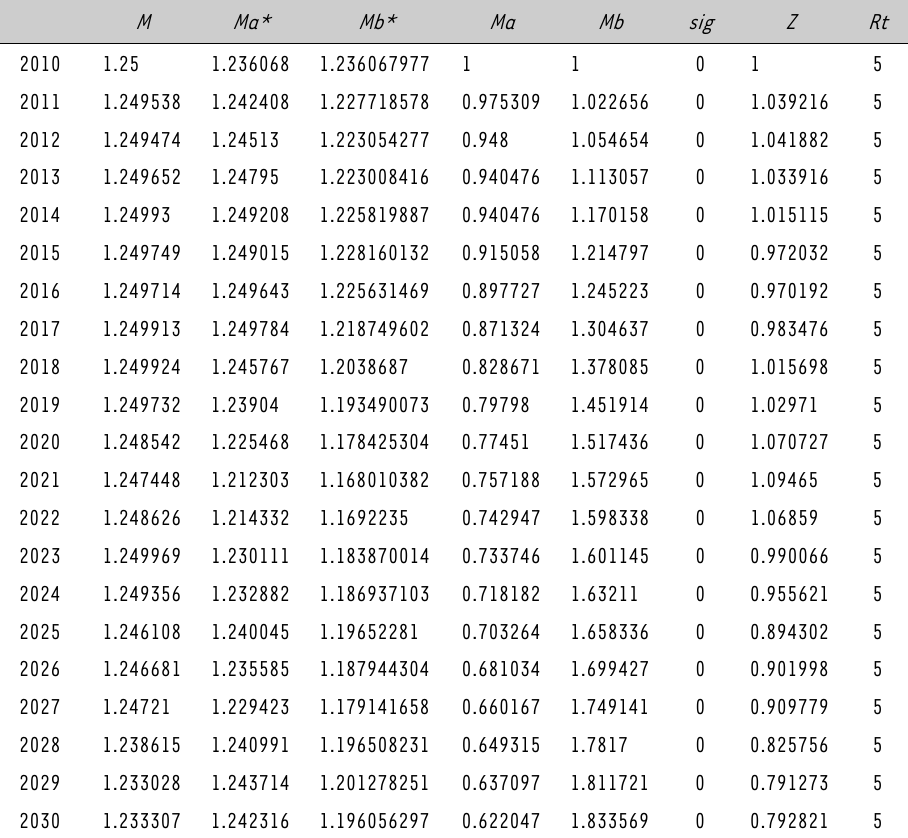
TABLE 8: Data used for South Africa to simulate the reaction function between the ‘environmentalist’ and the ‘energy producer’, when the rainfall increases and the ‘energy producer’ forces a policy shift in